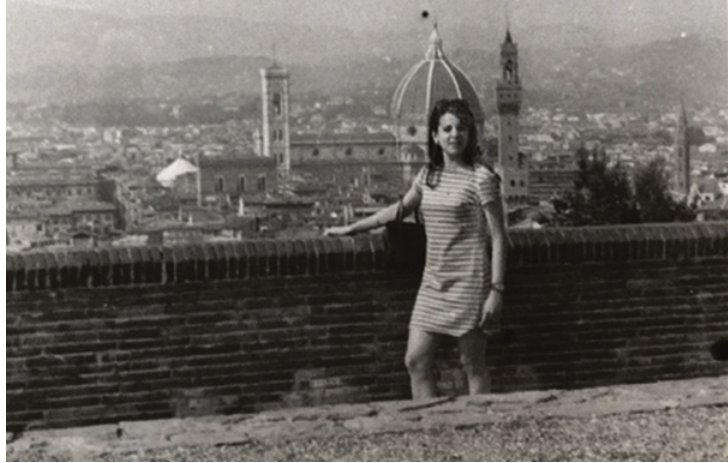
Figure 3 Christina Souyouldzoglou, at Forte di Belvedere, with Florence in the background in 1968. (Source: Christina